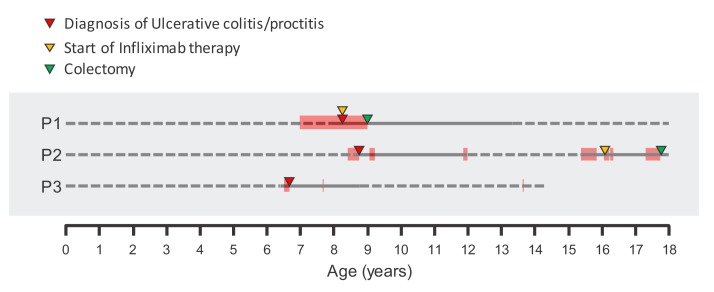
Clinical course of affected probands.Critical clinical events are noted. Full line represents active follow-up and dashed line represents no active follow-up. Red bars along each proband’s timeline represent periods of time of reported colitic symptoms (bloody diarrhea and abdominal pain). Time of diagnosis, infliximab therapy initiation and time of colectomy are also noted.